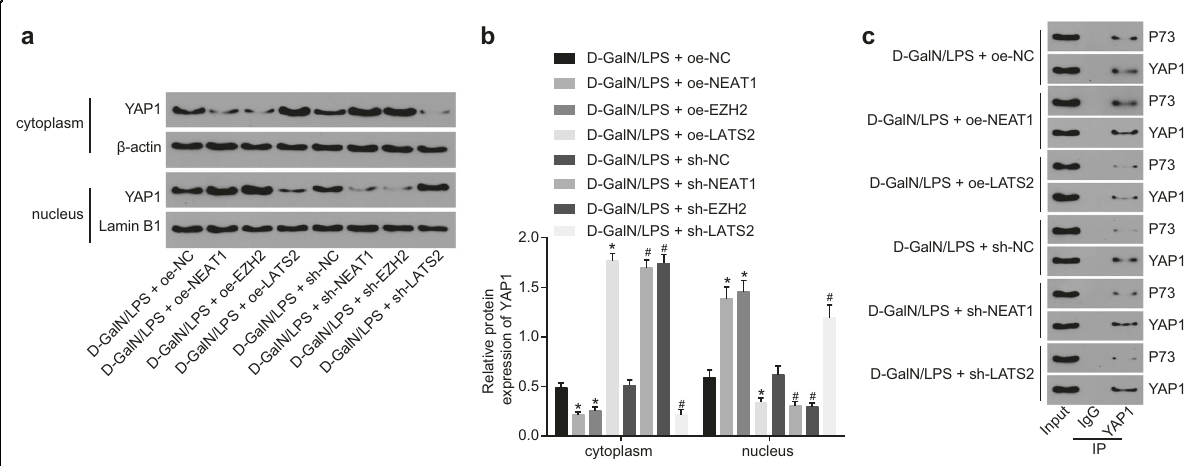
Fig. 6 LncRNA NEAT1/EZH2/LATS2 activates the Hippo/YAP signaling pathway. The protein expression patterns of YAP1 in HL-7702 cells treated with D-GalN/LPS quanti fi ed by western blot analysis ( a ). Quanti fi cation of protein expression in a ( b ). The binding relationship between YAP1 and P73, assessed by coIP ( c ). * p < 0.05 vs. the D-GalN/LPS + oe-NC group; # p < 0.05 vs. the D-GalN/LPS + sh-NC group. D-GalN/LPS + oe-NC group, HL- 7702 cells treated with oe-NC in the presence of D-GalN/LPS treatment; D-GalN/LPS + sh-NC group, HL-7702 cells treated with sh-NC in the presence of D-GalN/LPS treatment; D-GalN/LPS + oe-NEAT1 group, HL-7702 cells treated with oe-NEAT1 in the presence of D-GalN/LPS treatment; D-GalN/LPS + oe-LATS2 group, HL-7702 cells treated with oe-LATS2 in the presence of D-GalN/LPS treatment; D-GalN/LPS + sh-NEAT1 group, HL-7702 cells treated with sh-NEAT1 in the presence of D-GalN/LPS treatment; D-GalN/LPS + sh-LATS2 group, HL-7702 cells treated with sh-LATS2 in the presence of D-GalN/LPS treatment. Statistical data are described as mean ± standard deviation. One-way analysis of variance was used for comparisons among multiple groups, followed by Tukey ’ s post hoc test. The experiment was repeated three times independently. lncRNA NEAT1 long noncoding RNA nuclear-enriched abundant transcript 1, LATS2 large tumor-suppressor kinase 2, D-GalN/LPS, D-galactosamine/lipopolysaccharide, NC negative control, coIP